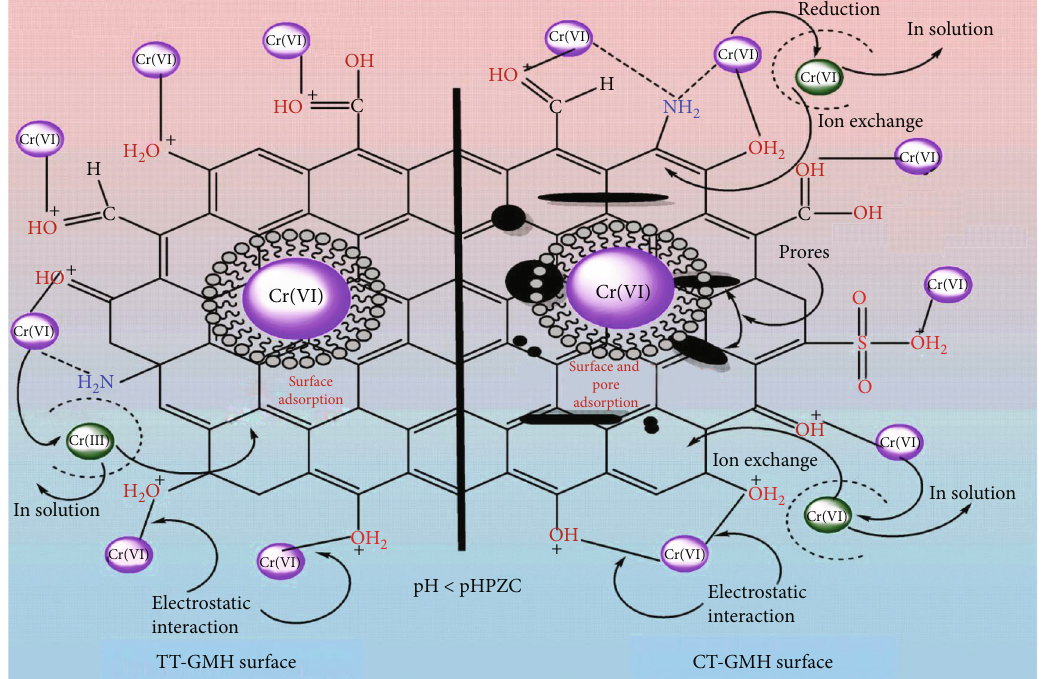
Figure 9: Adsorption and desorption study of adsorbents TT-GMH and